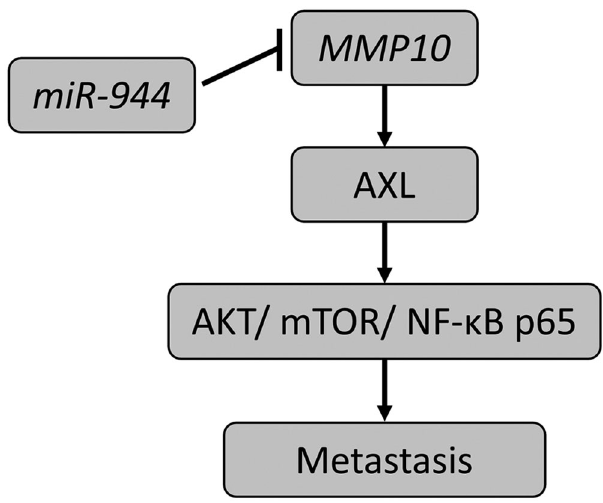
Fig. 6 Model depicting miR-944/MMP10/AXL - axis to regulate metastasis in tongue cancer. The working model demonstrating the role of MMP10 in promoting metastasis via activation of AXL signaling pathway and is negatively regulated by miR - 944 in tongue cancer.